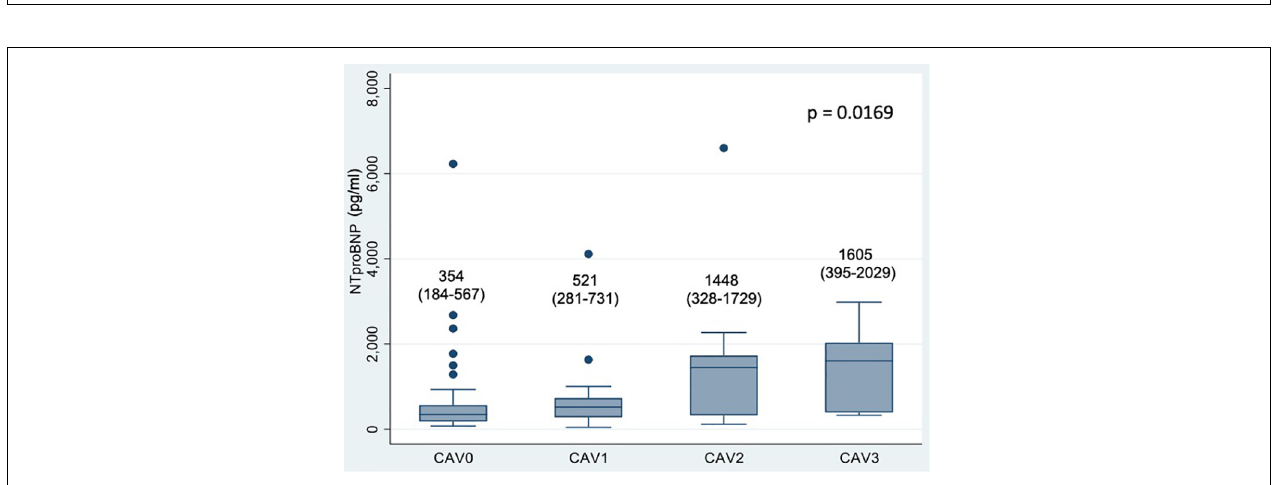
Frontiers in Cardiovascular Medicine |